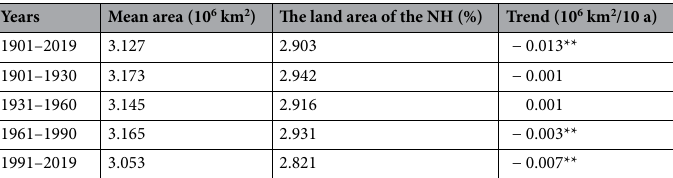
y = -0.0013x + 3.206